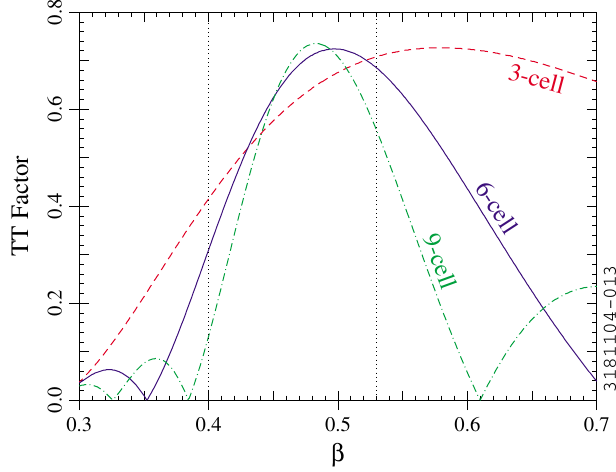
FIG. 1. (Color) Comparison of the (cid:6) 0 : 61 cell (SNS), a (cid:6) (TTF, scaled to 805 MHz).